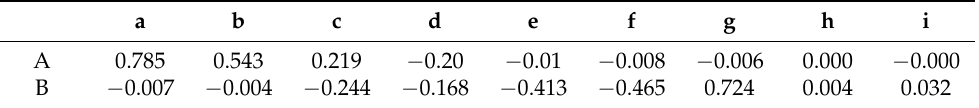
Table 3. Coefficients for the ground state wave functions of iron ions in the antiferromagnetic phase. The wave functions for the opposite signs of the molecular field parameters I ( A / B ) can be obtained from those given here by the time sign reversal operation.